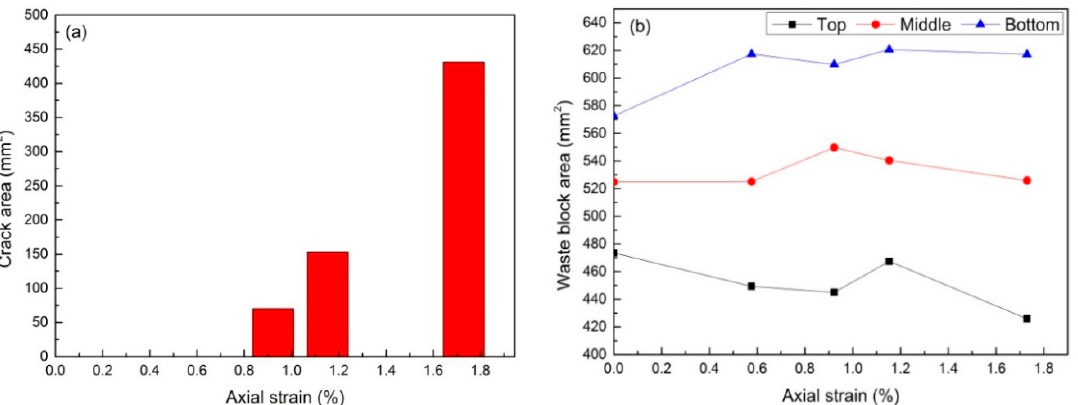
Figure 14. Structural changes in the CWRB sample during deformation. ( a ) Total crack area changes; ( b ) Changes of the waste rock content at the top, middle, and bottom scanning sections.